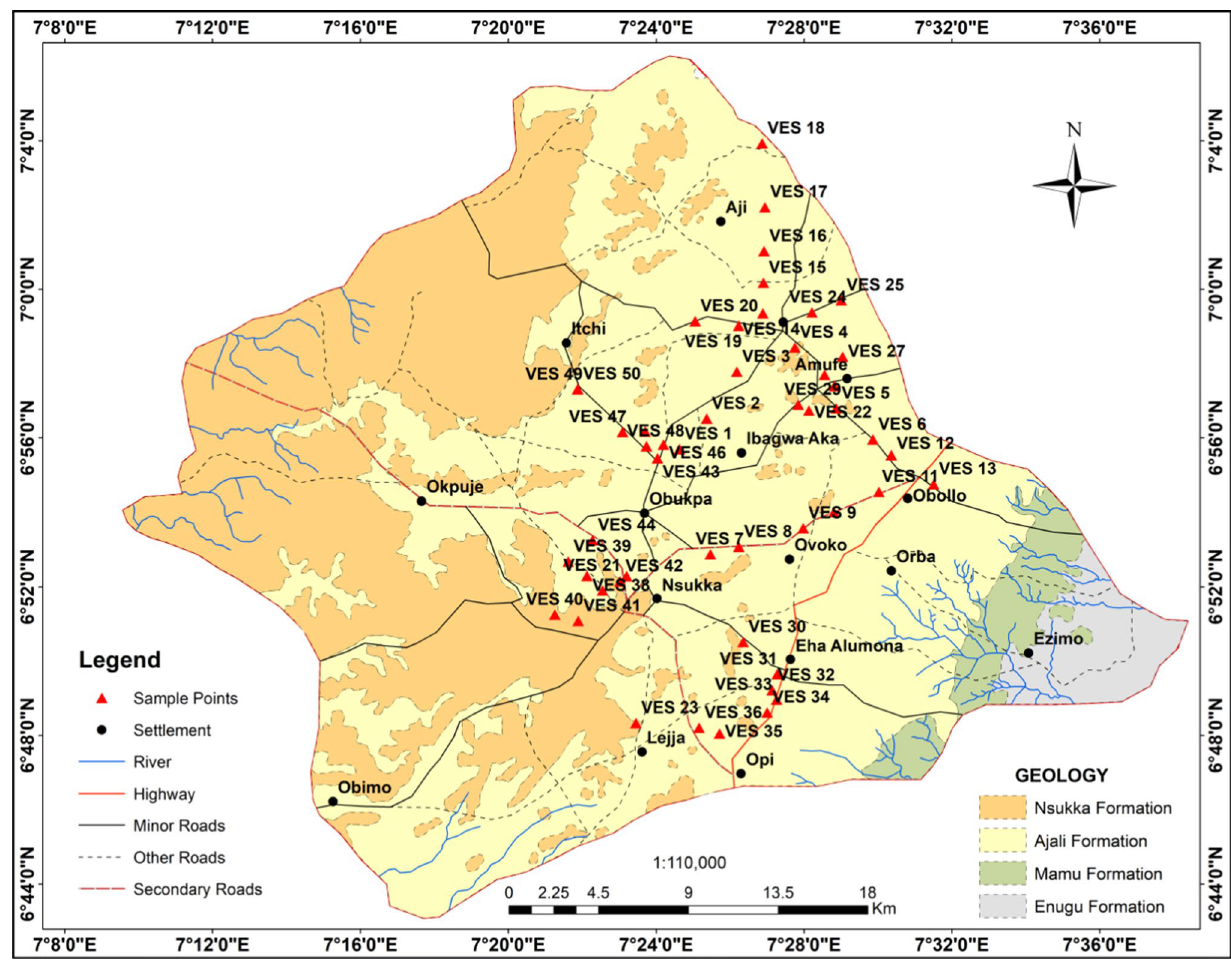
Fig. 2 Map showing the Geology of the study area and sampled VES